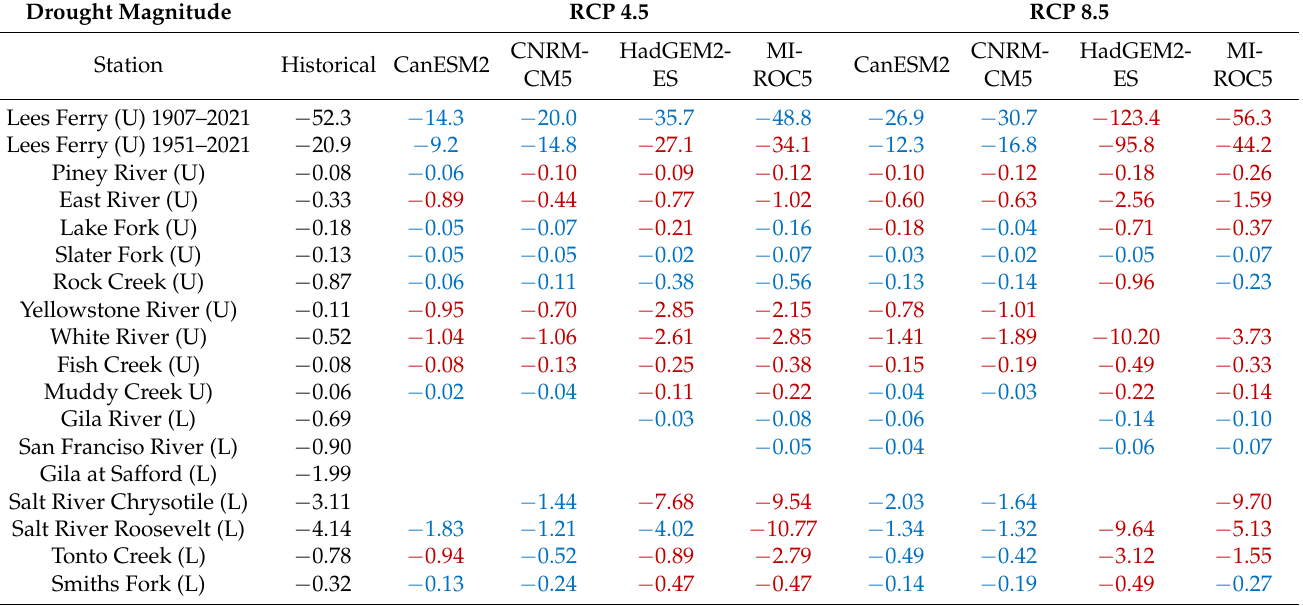
Table 3. Magnitude (in MAF) of drought and surplus periods for Upper (U) and Lower (L) Basin stations based on 1951–2021 for all stations and also the time period 1907–2021 for Lees Ferry. Blue values are higher than the historical record and red values are lower (Note: 1 MAF = 1233 million cubic